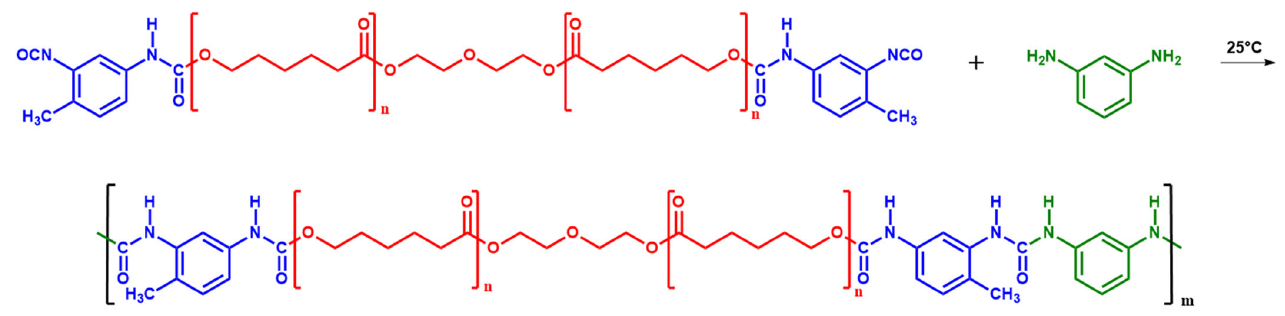
Figure 2. Scheme of reactions for the multiblock PUU synthesis on the example of S1 and S2 com ‐ positions.